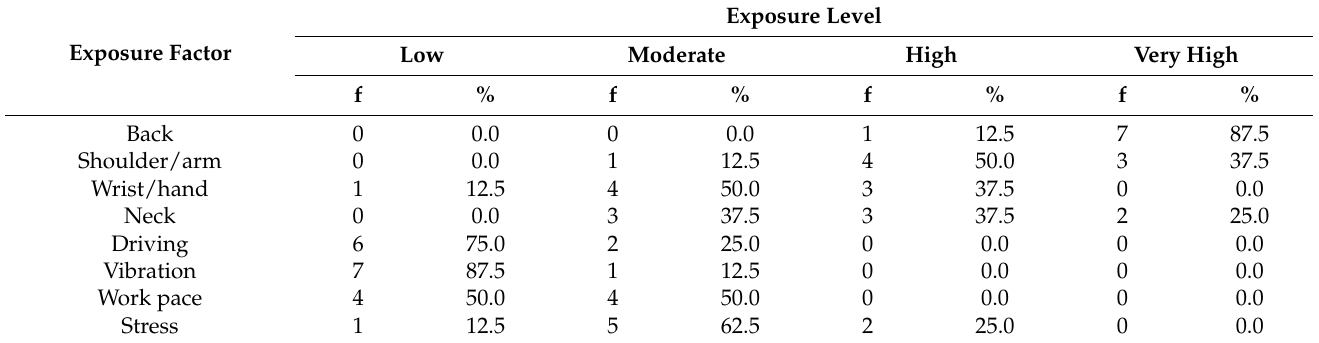
Table 12. Frequency (f) and percentage (%) of processors for each factor according to the level of exposure based on the scores proposed by the QEC method ( n =